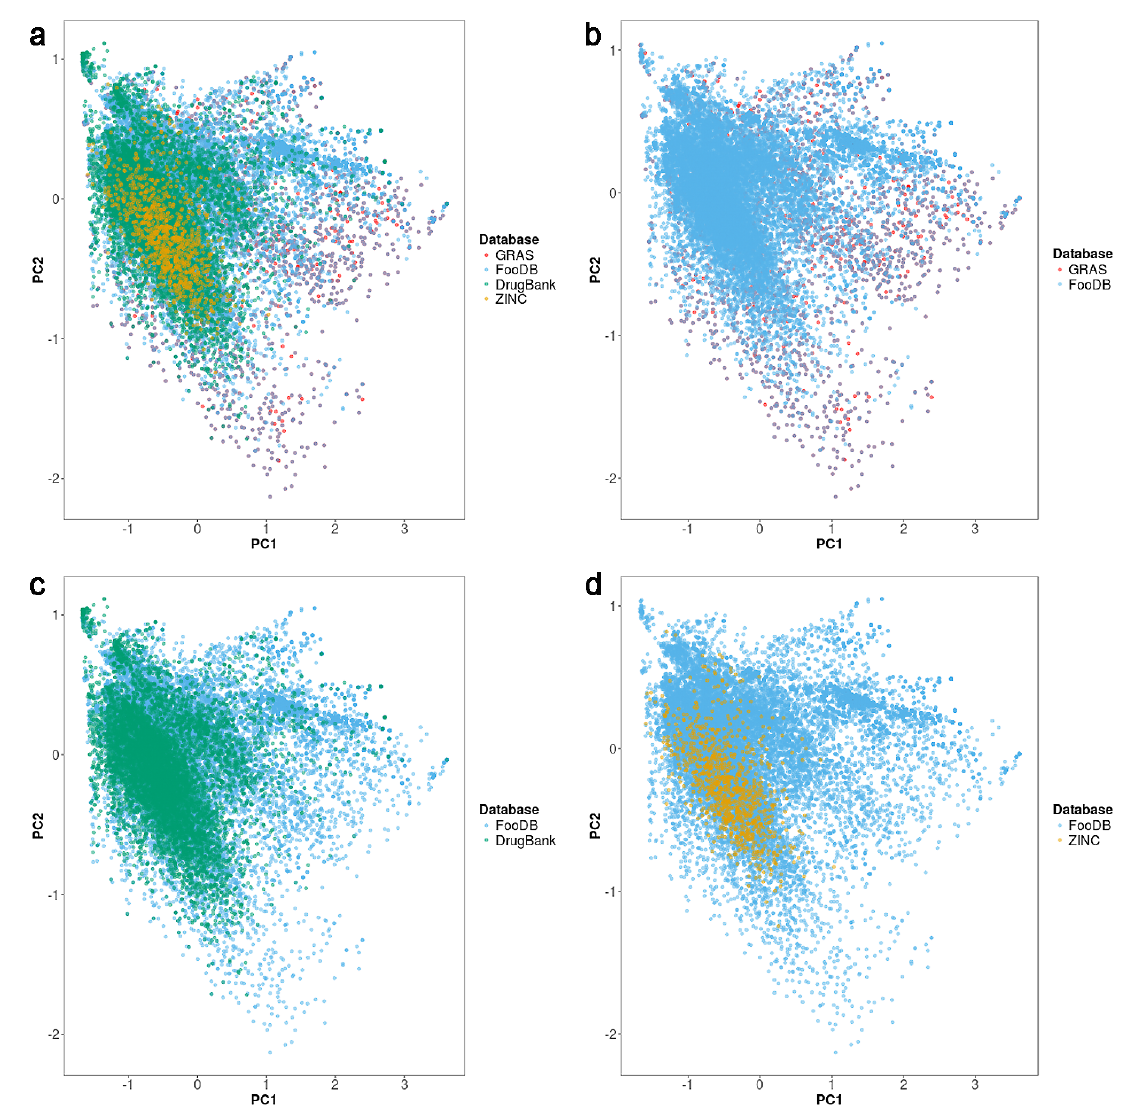
Figure 1. Representation of the chemical space of FooDB. The visual representation was generated with ChemMaps (Naveja & Medina-Franco, 2017). a ) Comparison of FooDB with three reference collections. Panels b – d ) show comparisons of FooDB with individual data